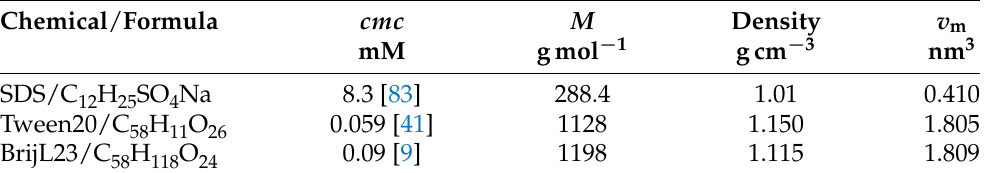
Table A3. Critical micelle concentrations cmc , molar mass M as given by the manufacturer, the deter- mined densities and the molecular volume v m of the used surfactants.